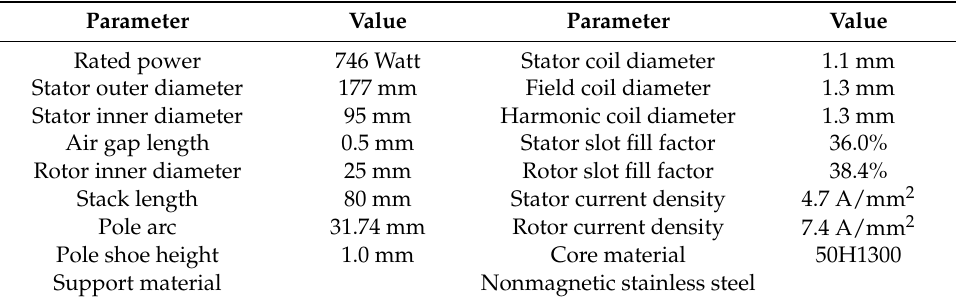
Table 3. Major machine parameters of prototype machine.